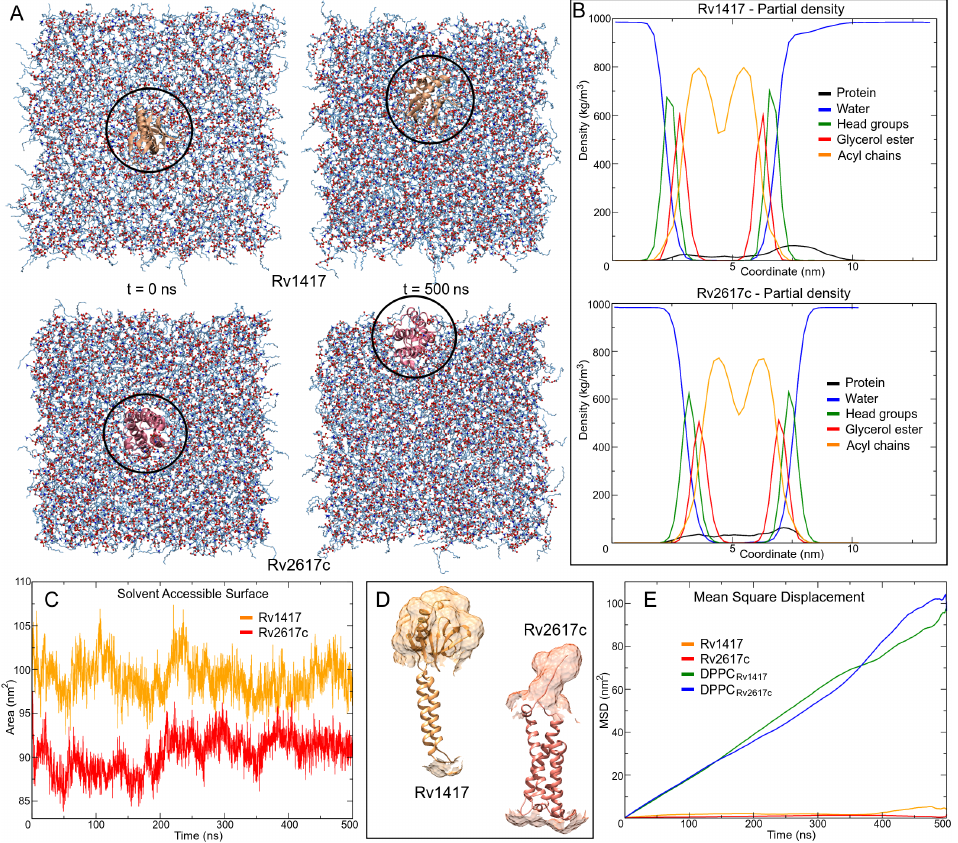
Figure 4. Protein–membrane systems. ( A ) Movement of proteins through the lipid bilayer. ( B ) Density profiles of system components along the z -axis. ( C ) Solvent accessible surface area (SASA) calculation. ( D ) Connolly surface of the outer protein regions. ( E ) Mean square displacement (MSD) calculations were used to measure the lateral diffusion of protein and lipid head groups. MSD values of lipids are based on the diffusion of DPPC headgroup P8